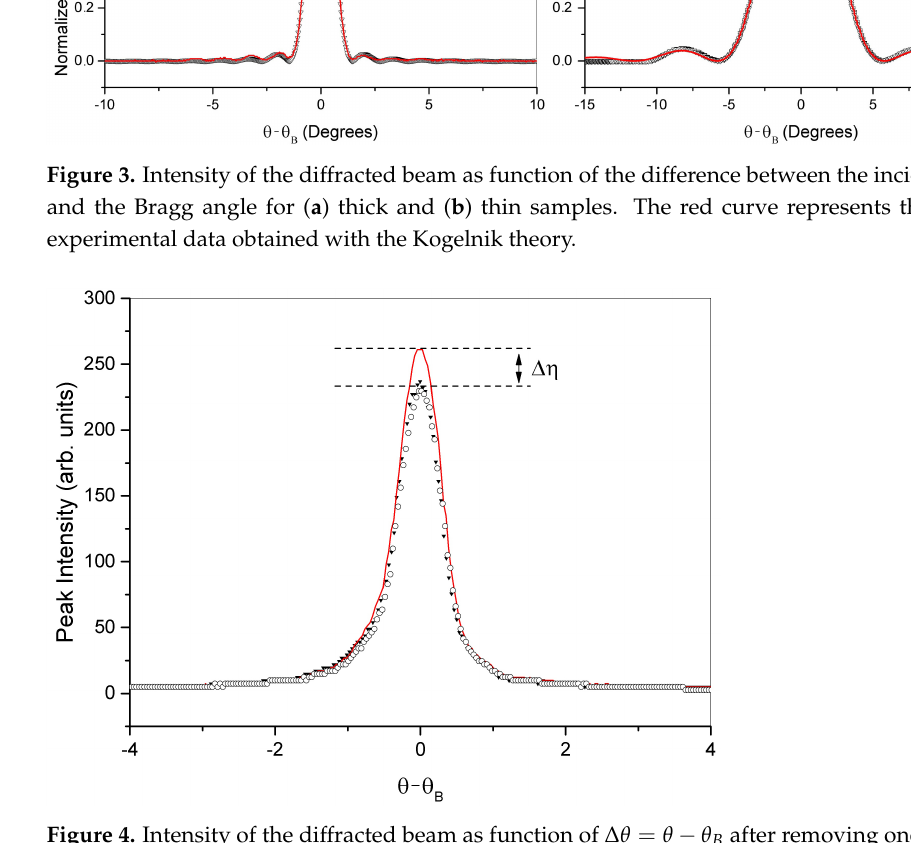
Figure 4. Intensity of the diffracted beam as function of ∆ θ = θ − θ B after removing one glass slide (empty circles), after 30 min of exposure to denatured 90% alcohol vapors (continuous red line), after heating with a warm-air gun for a few minutes (filled